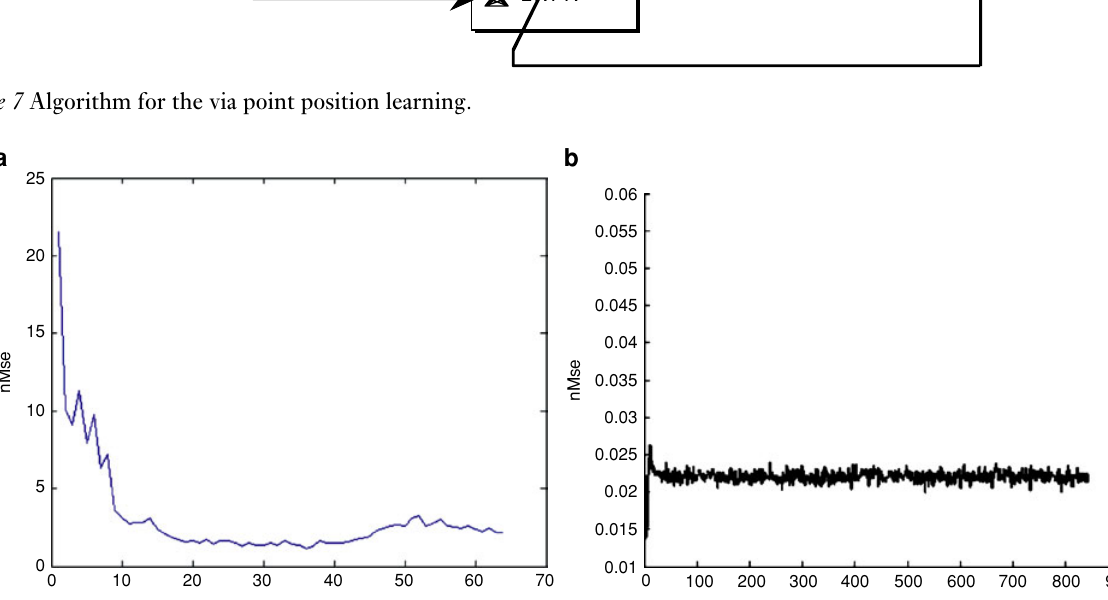
Figure 8 Learning curves. (a) Final arm configuration. (b) Via